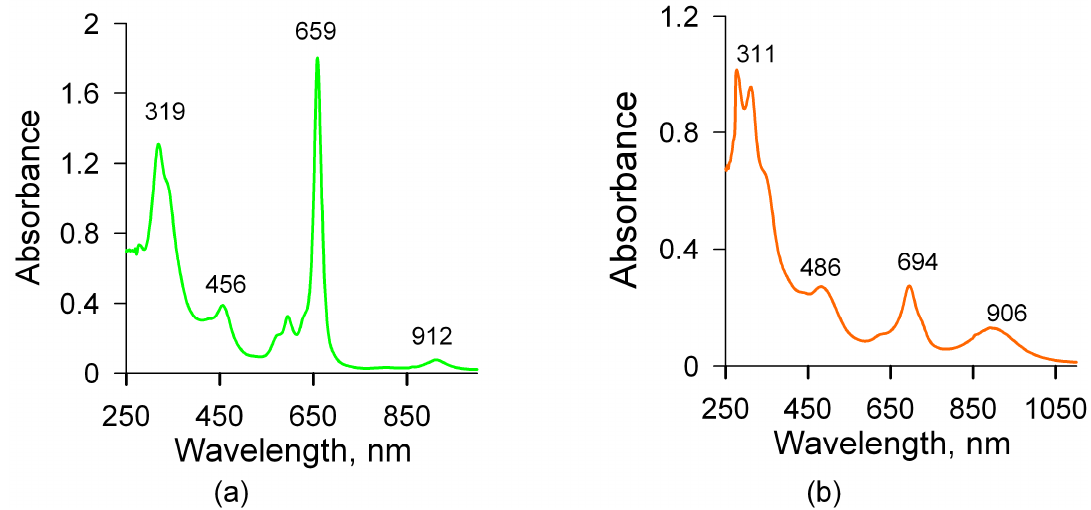
Figure 3. Terminal UV-Vis spectra in benzene of ( a ) YbPc 2 (green form), and ( b ) YbPc 2 @TFA (orange form).